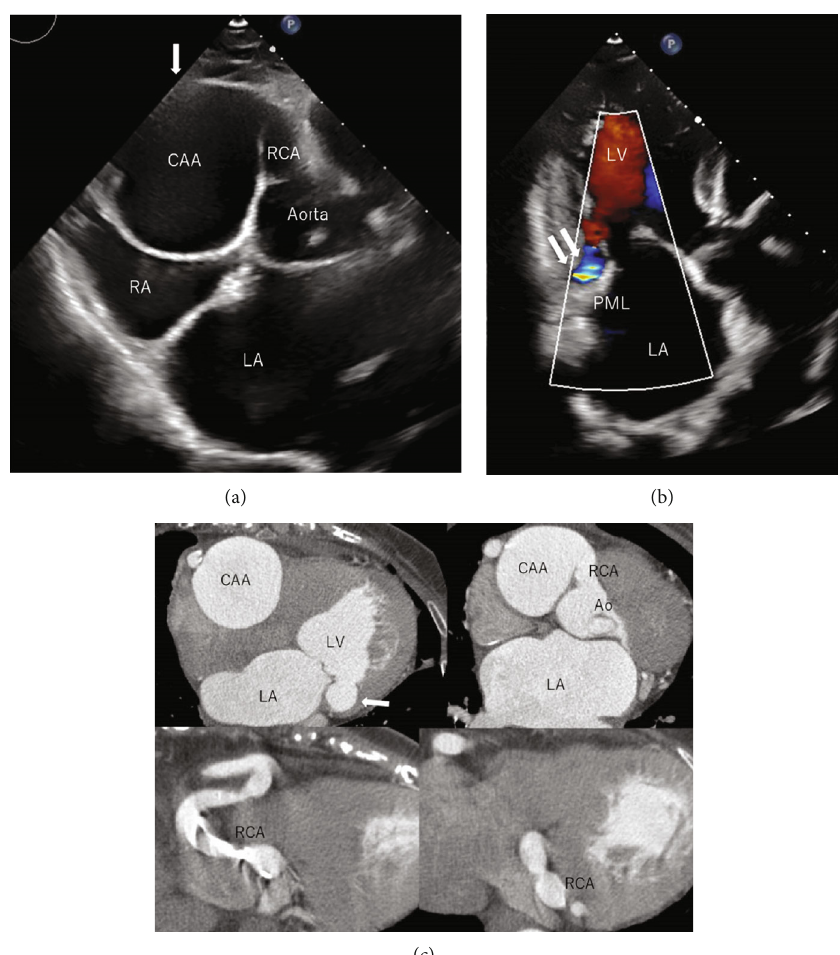
Figure 1: (a, b) Preoperative ultrasound echocardiography. CAA ( ↓ ) CAF ( ↓↓ ). (c) MDCT of coronary artery. CAF ( ↓ ). CAA: coronary artery aneurysm; RCA: right coronary artery; RA: right atrium; LA: left atrium; LV: left ventricle; PML: posterior mitral re fl et; Ao: ascending aorta.